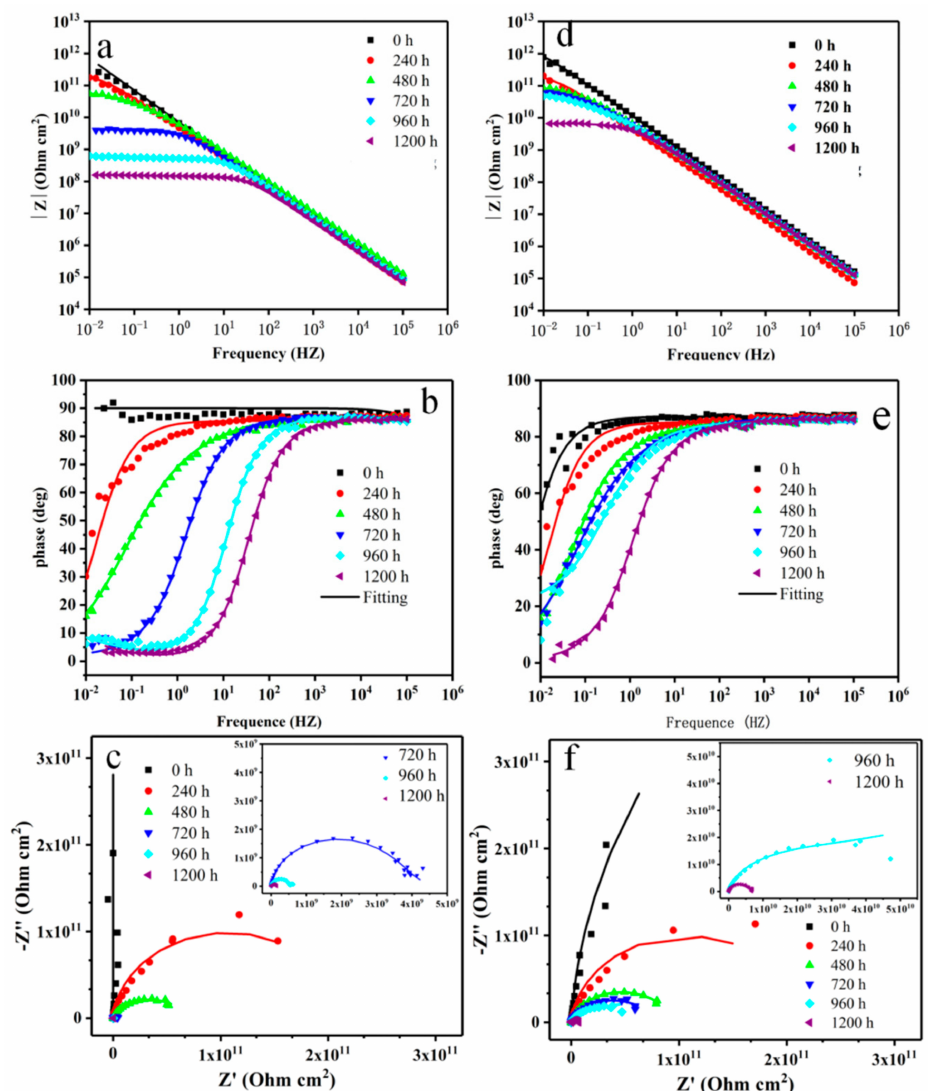
Figure 8. Impedance plots of ( a – c ) unmodified and ( d – f ) modified mica coatings immersed in 3.5 wt.% NaCl